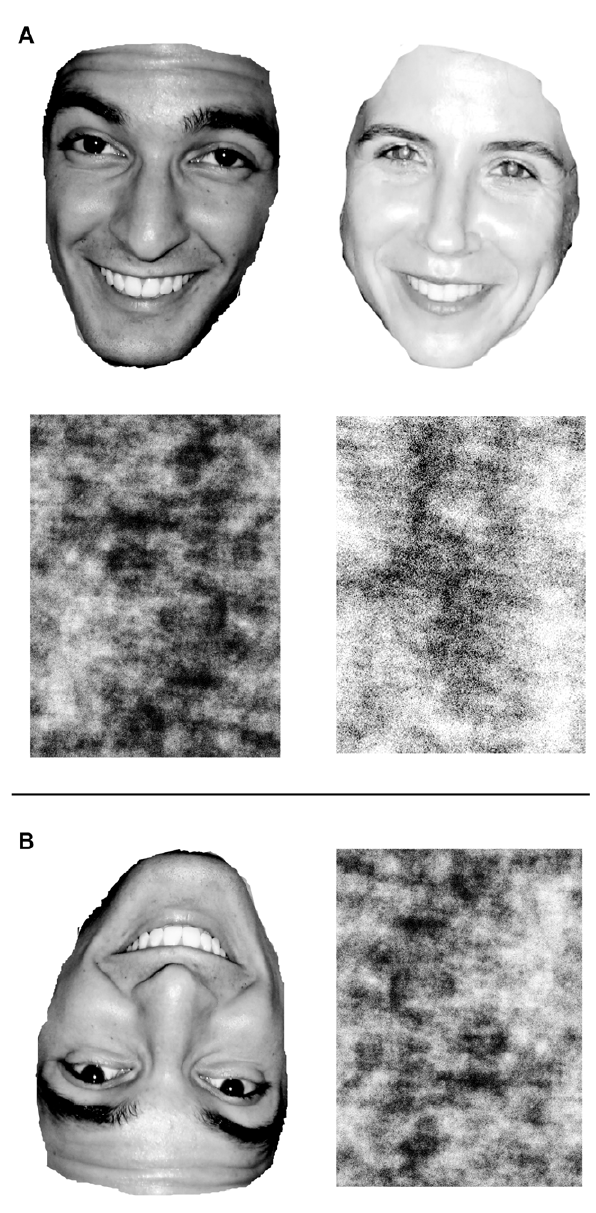
Figure 1. Sample stimuli from the sexual orientation detection task. (a) Example female face and backward mask (Experiments 1 and 2) and example male face and backward mask (Experiment 1); (b) lightened male face and backward mask (upside-down; Experiment